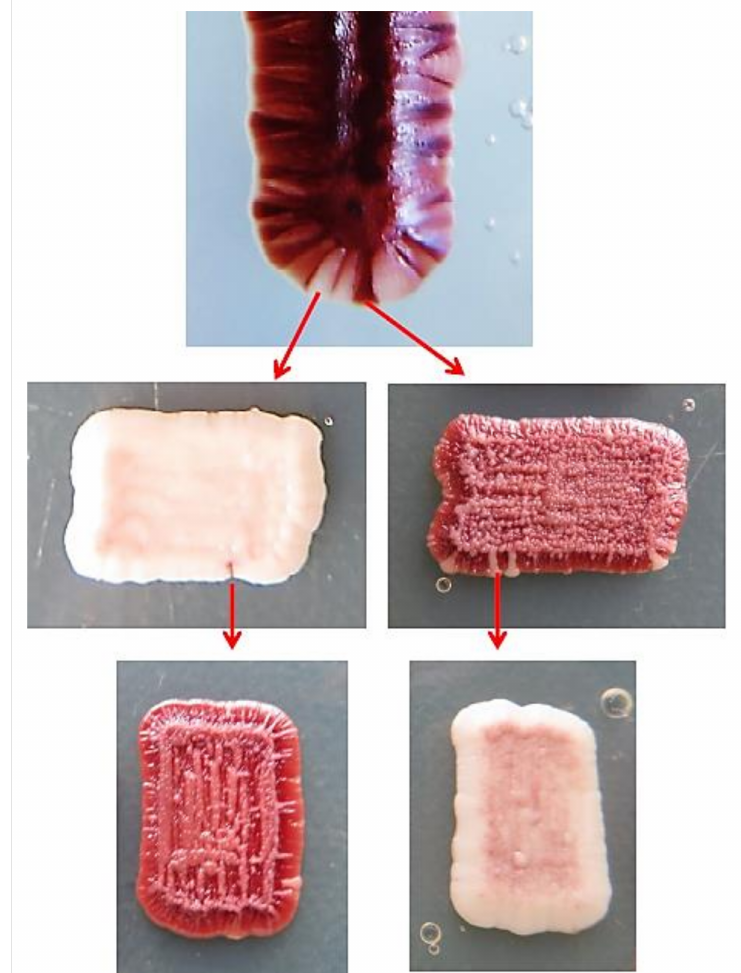
Figure 3. Segregation of pulcherrimin production (pigmentation